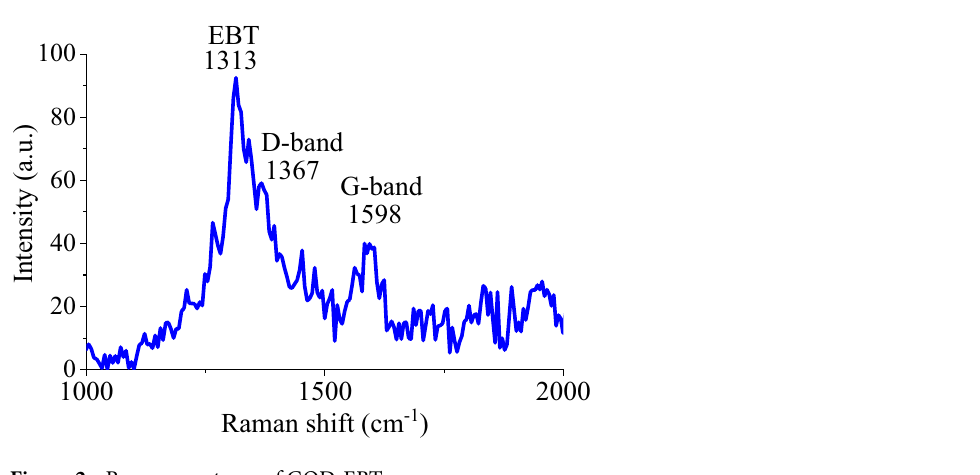
Figure 2. Raman spectrum of